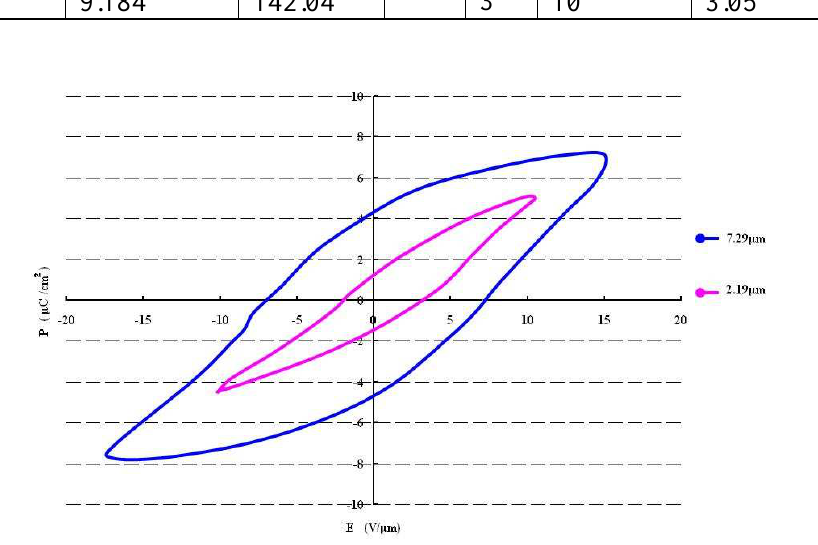
Figure 5. Hysteresis loops of PZT films with thicknesses of 2.19 m m and 7.29 m m in applied electric fields of 20 V/ m